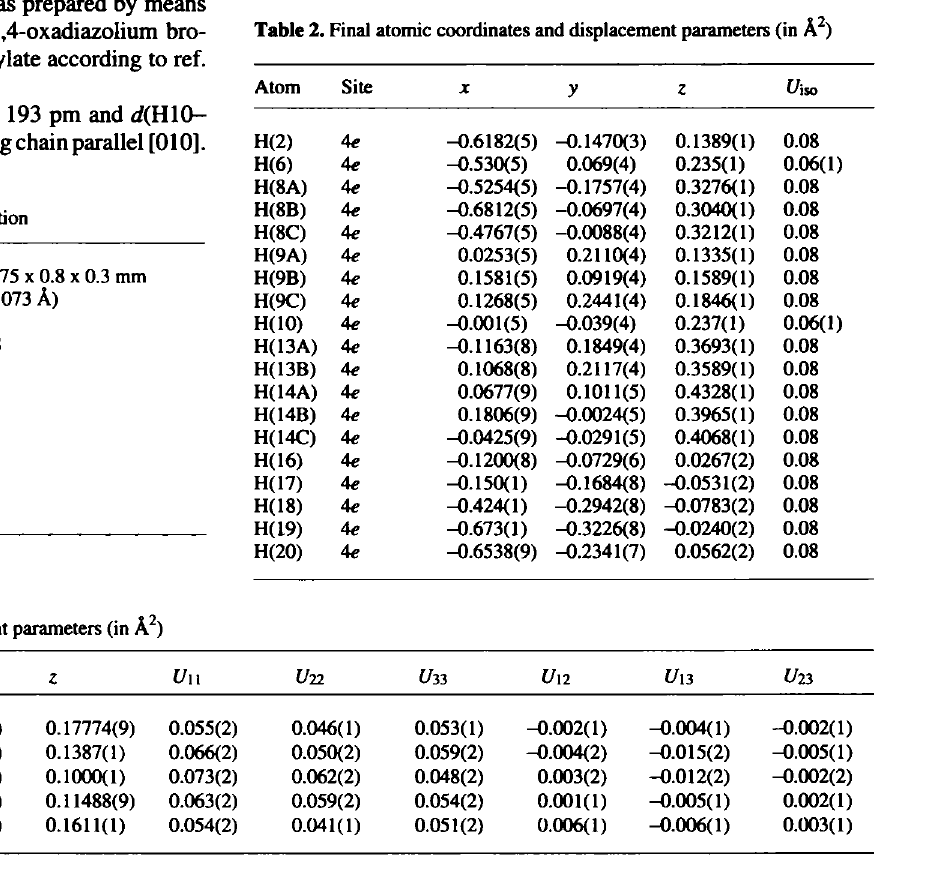
Table 2. Final atomic coordinates and displacement parameters (in Л^)